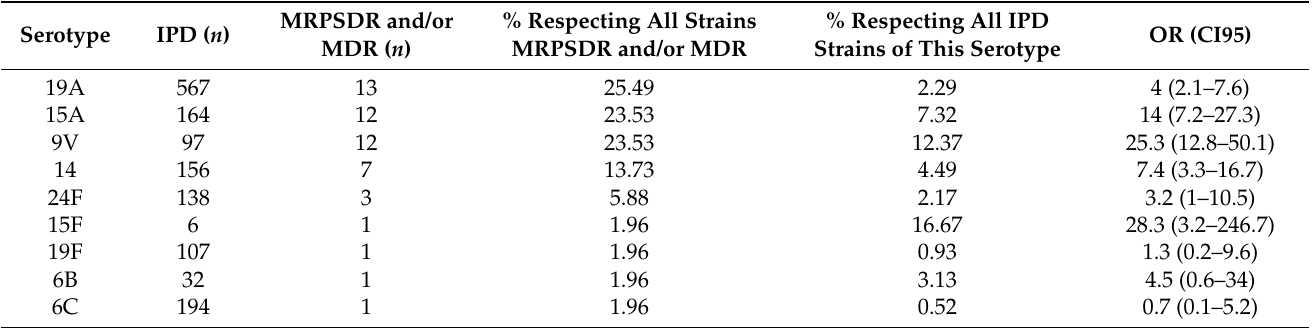
Table 1. Pneumococcal serotypes with multidrug-resistant at standard dosing regimen of penicillin and/or multidrug-resistant in the Madrid Region during the period 2007 to